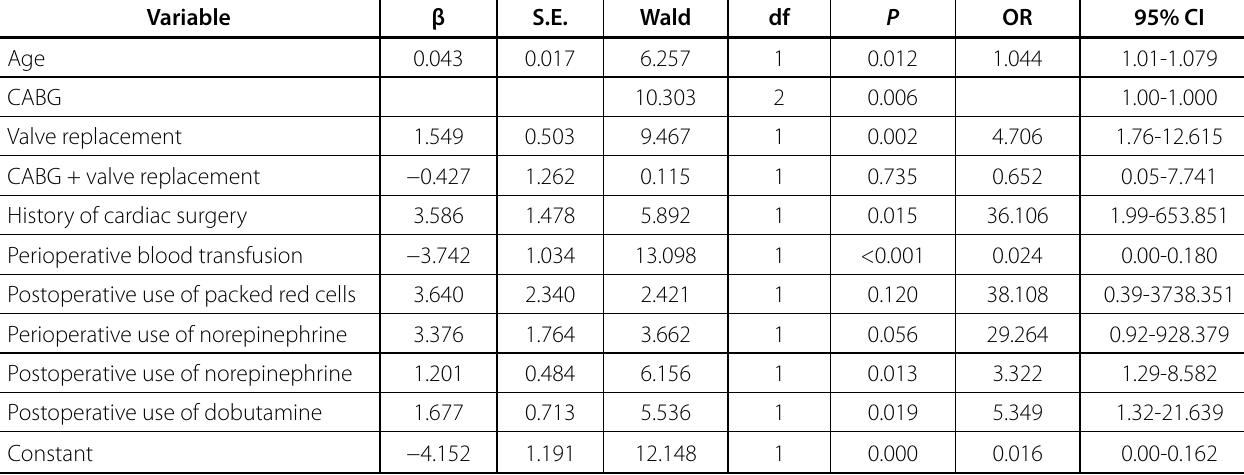
Table 4 . Multivariate analysis of risk factors associated with the development of acute kidney injury after cardiac surgery. Variable